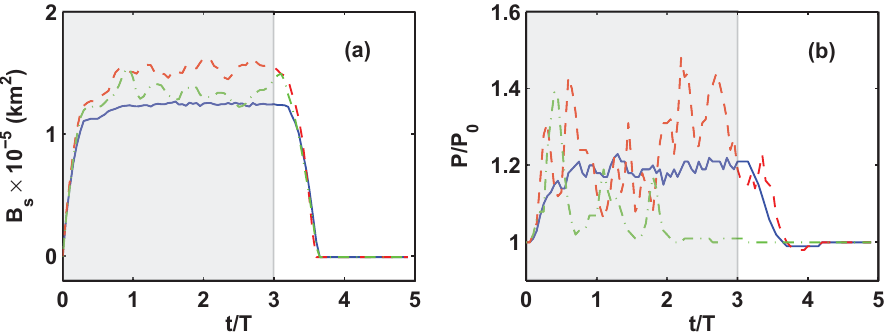
Fig. 3. Time evolution of the phytoplankton patch size B s (a) and the phytoplankton concentration 7 grid points apart from the upwelling re- gion (b) for three pairs of Eulerian time and length scales ( τ,λ ) for the Gaussian flow, Eqs. (2–4). Blue solid line (cid:0) log 10 (τ/T ), log 10 (λ/L) (cid:1) = ( − 0 . 5 , − 0 . 5 ) , red dashed line ( − 0 . 5 , 1 ) and green dashed-dotted line ( − 0 . 5 , 1 . 5 ) . Set of parameters: G( 0 , 0 ) = 225, N x = N y = 128 and active upwelling time T f /T = 3 (gray